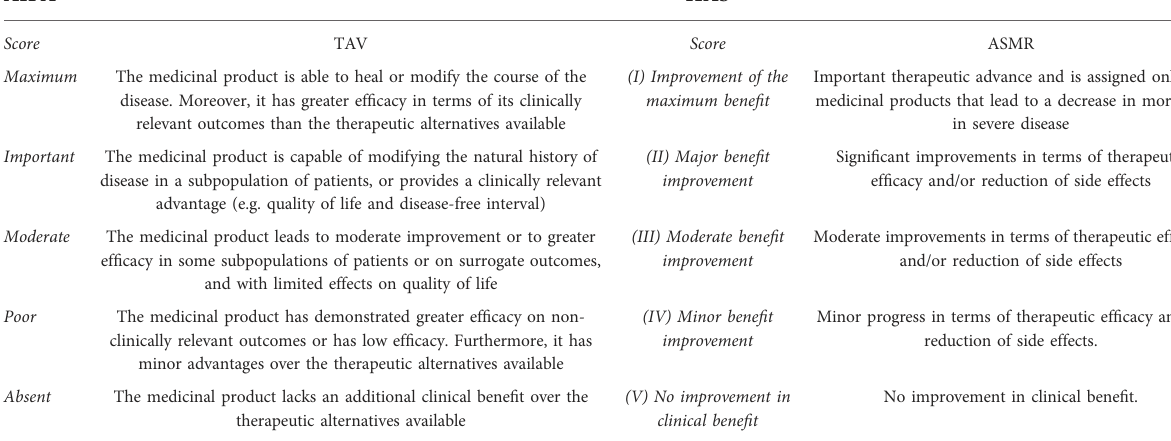
TABLE 1 AIFA therapeutic added value and HAS ASMR scores.